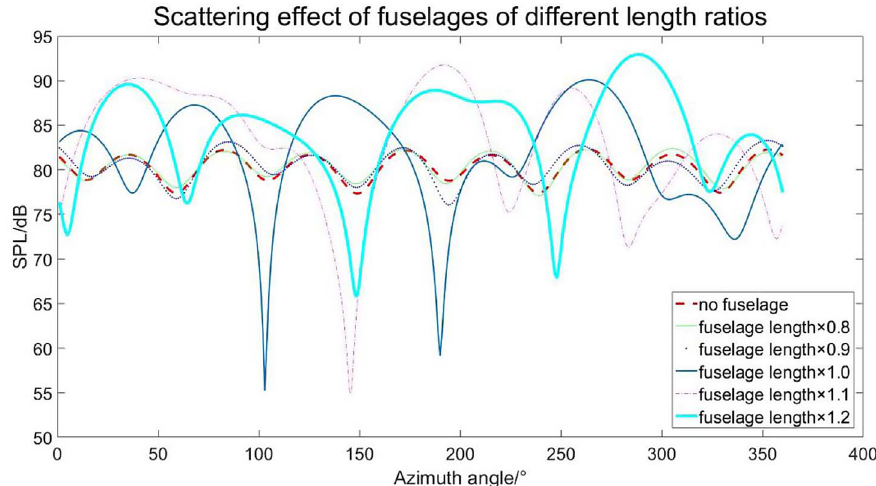
Figure 19. Scattering effect of fuselages of different length ratios.